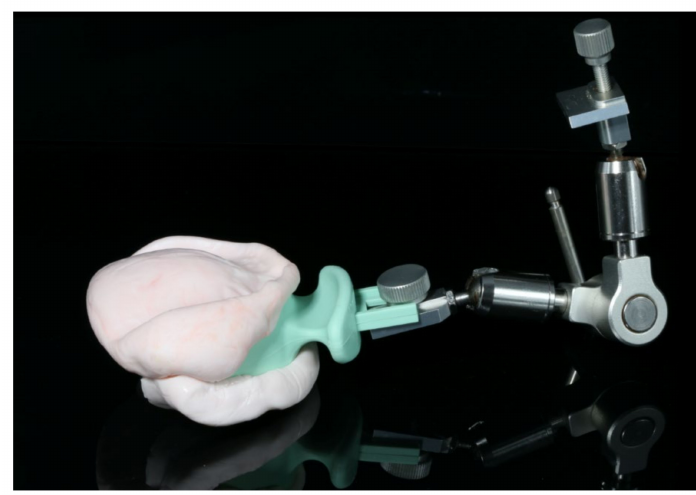
Figure 4. Preliminary bite registration taken during the first appointment.